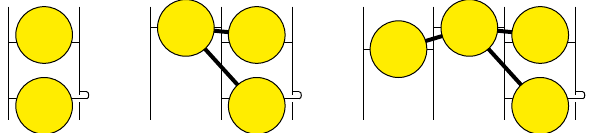
Figure 8 . Quiver structures in simpler brane diagrams for D 2 , D 3 and D 4 quiver